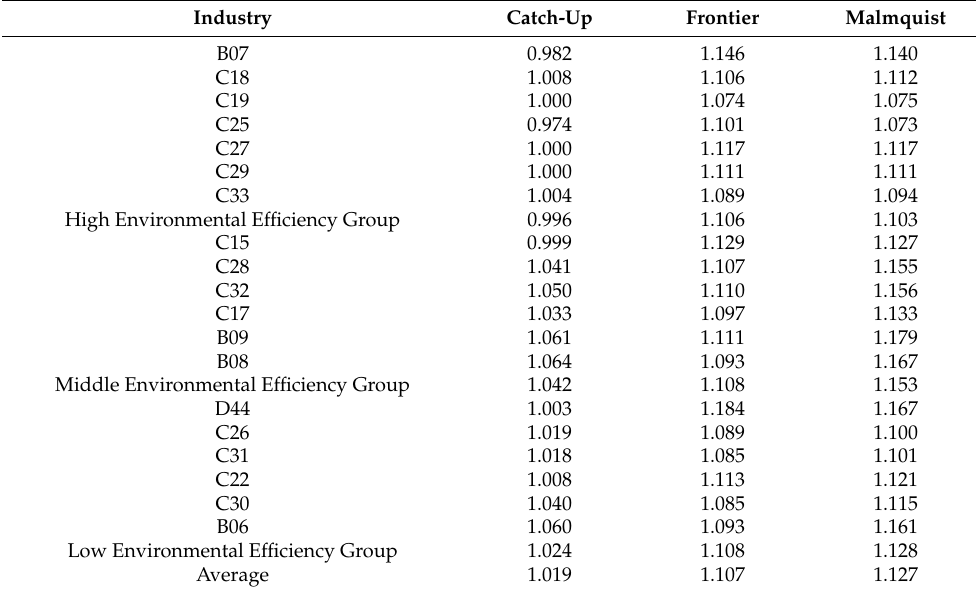
Table 6. MI decomposition results of heavy pollution